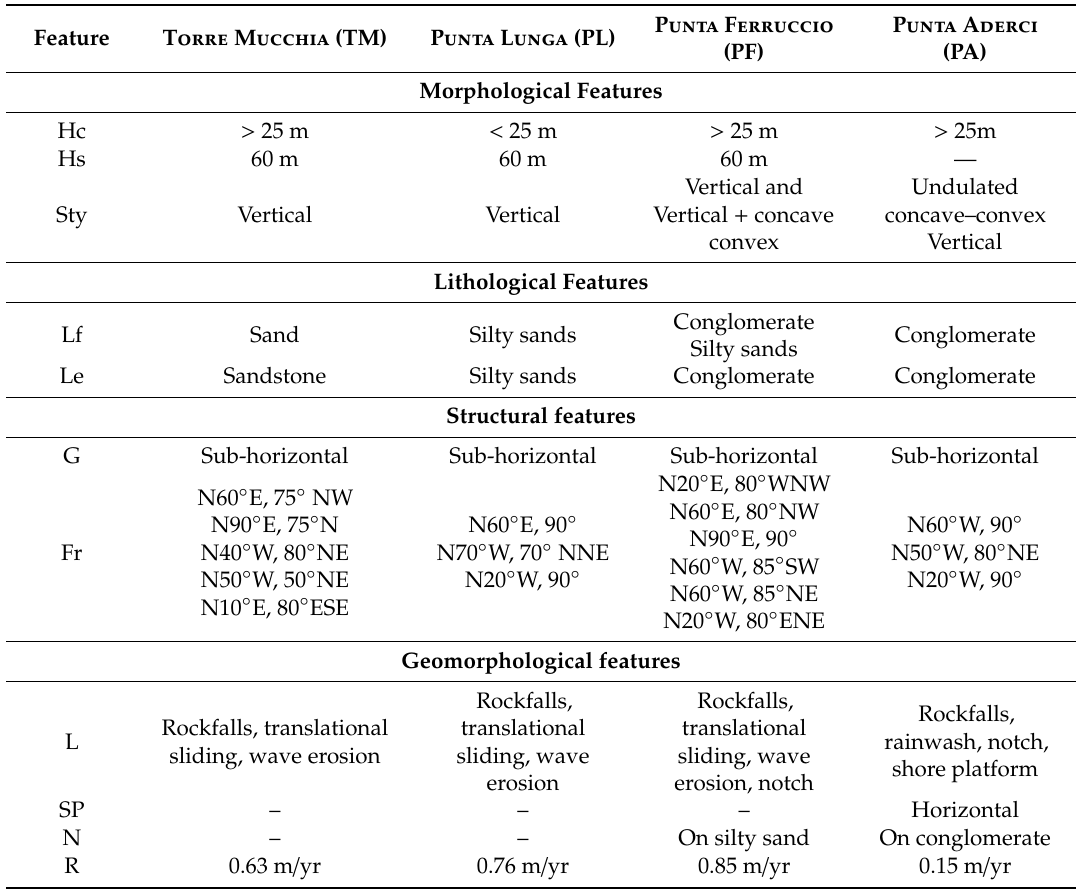
Table 2. The lithological, structural and geomorphological features of the four surveyed cli ff s (locations in Figure 1) (modified from Miccadei et al. [7]). Features: Hc: cli ff height; Hs: coastal slope